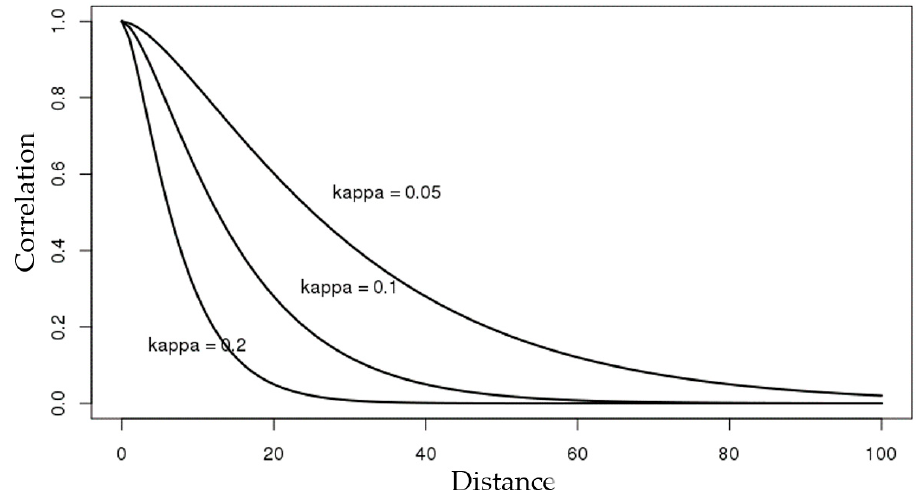
Figure 1. Matern correlation function curves corresponding to different values of 𝜅 .